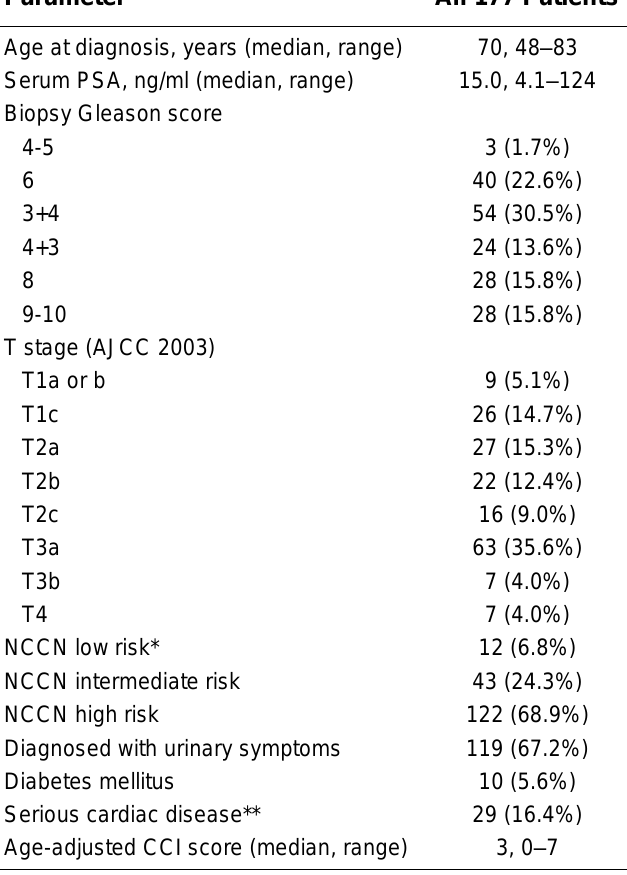
Baseline Parameters